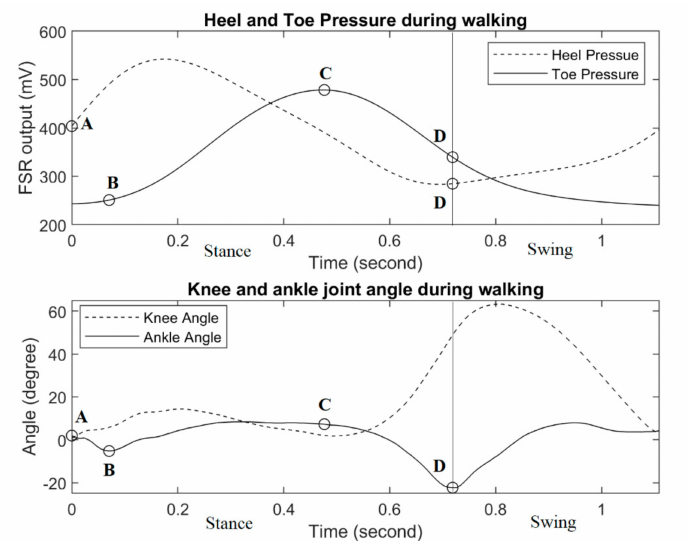
Figure 11. Responses of force-sensing resistors at important gait events, along with the corresponding ankle and knee joint trajectories. Point (A): Initial ground contact event, (B) Forefoot contact event, (C) Push-off event and (D) Toe-off